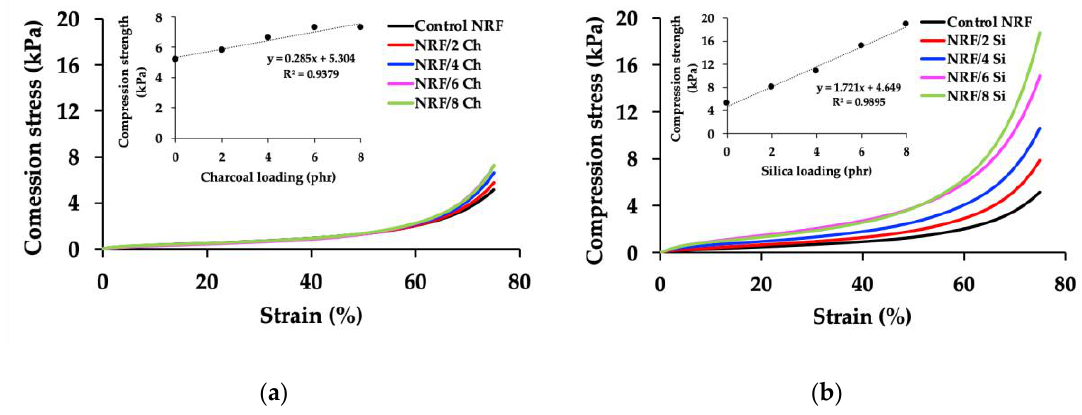
Figure 4. Compression stress of the NRFs: ( a ) NRF with charcoal loading; ( b ) NRF with silica loading.